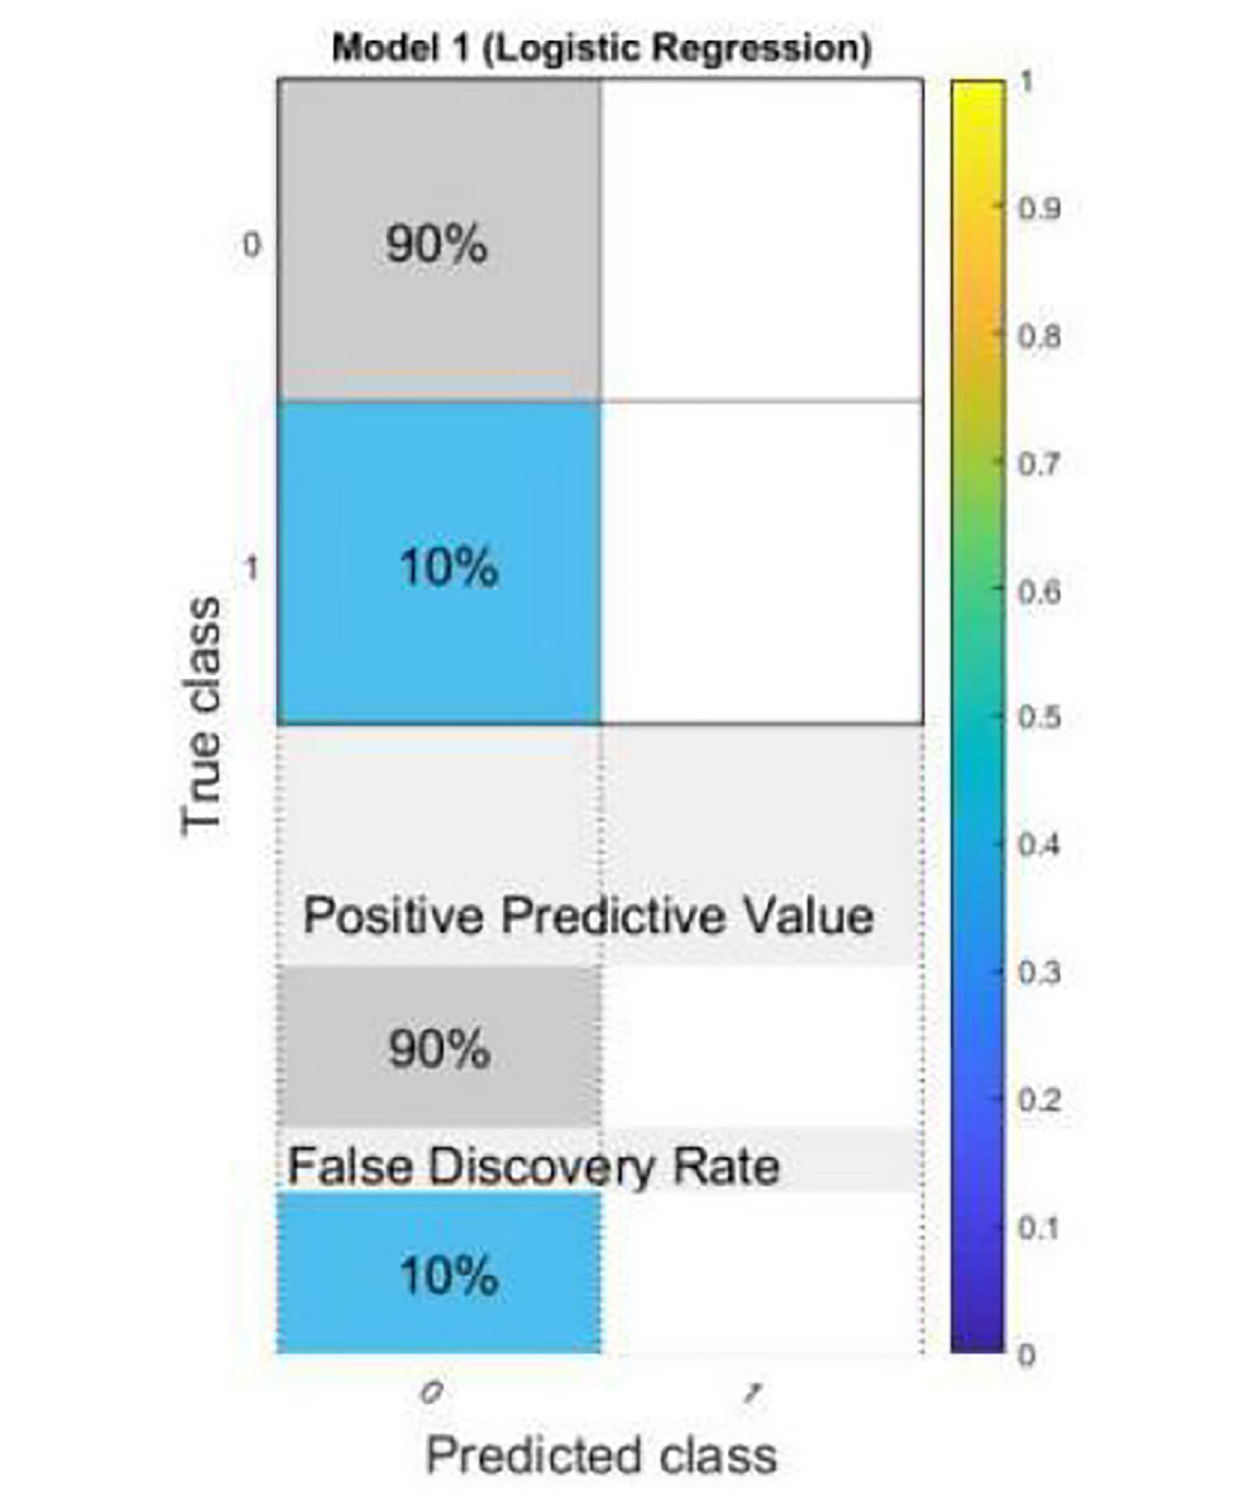
FIGURE 10 | Confusion matrix plot with positive predictive value and false discovery rate from logistic regression.